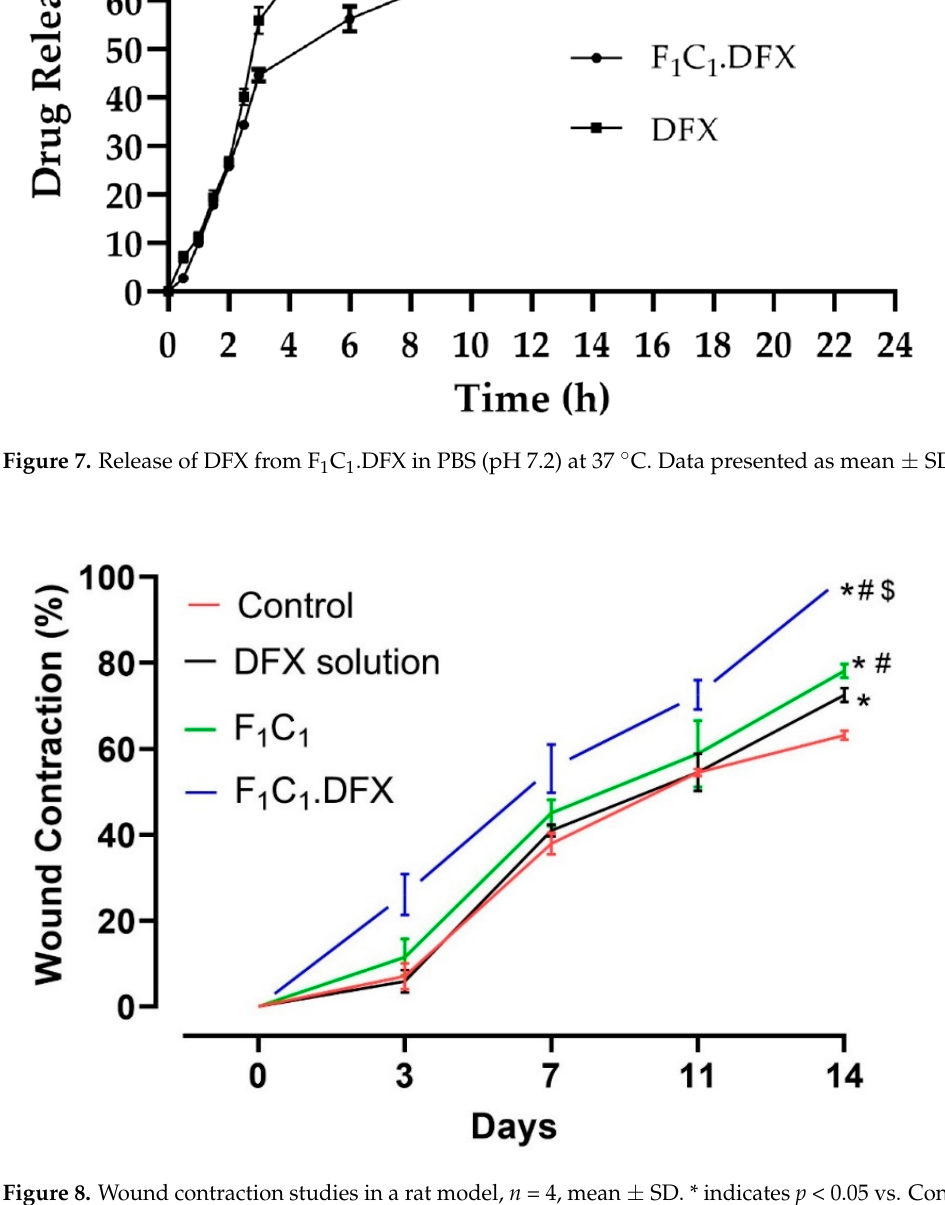
Figure 8. Wound contraction studies in a rat model, n = 4, mean ± SD. * indicates p < 0.05 vs. Control; # indicates p < 0.05 vs. DFX solution; $ indicates p < 0.05 vs F 1 C 1 .